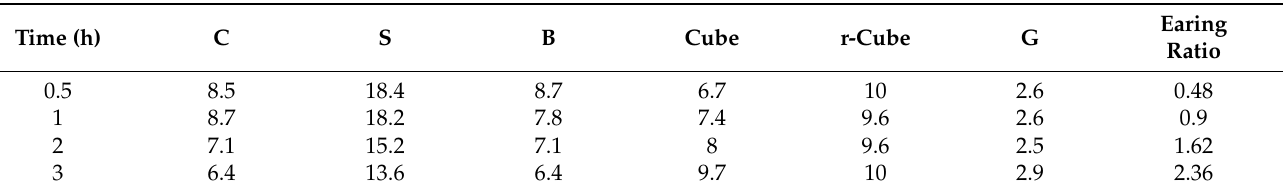
Figure 8. Volume fraction of texture components of AA5151 alloy at 250 ◦ C for 0.5, 1, 2, and 3 h. Table 4. Volume fraction of texture components (%) and earing ratios of AA5151 alloy at 250 ◦ C for 0.5, 1, 2, and 3 h.